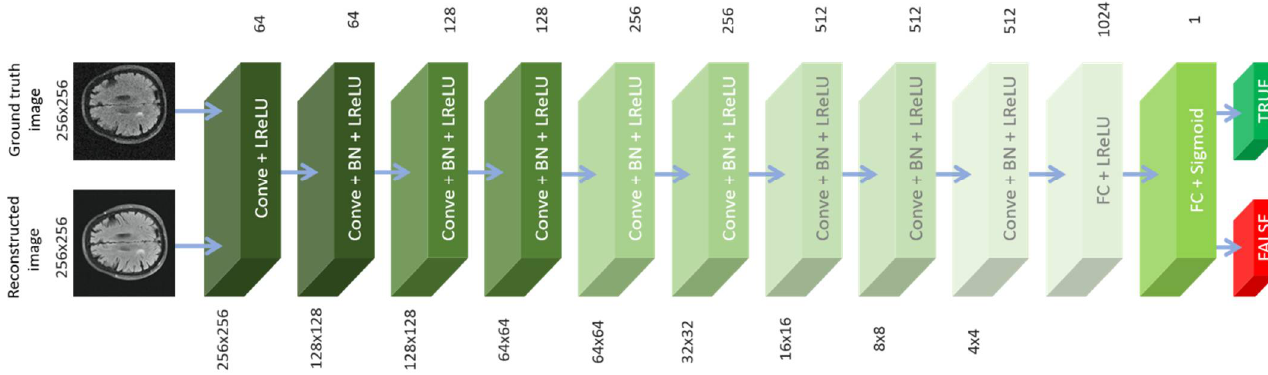
Figure 4. Generator architecture. Figure 4. Discriminator architecture . Figure 4. Discriminator architecture .